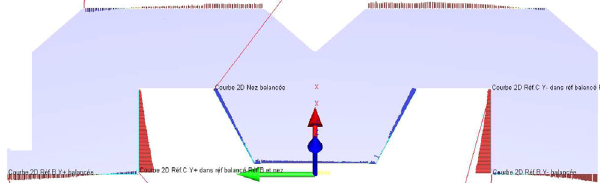
FIG. 11. Geometrical measurement results of a FeCo pre-series lamination.